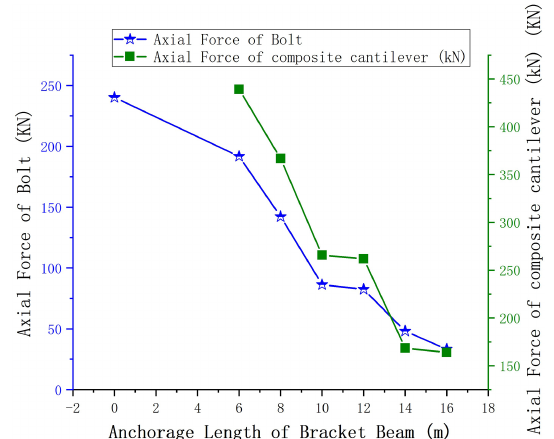
Figure 8. Relation curve of the cantilever beam length with the ax- ial force of the cantilever beam and the axial force of the composite cantilever.